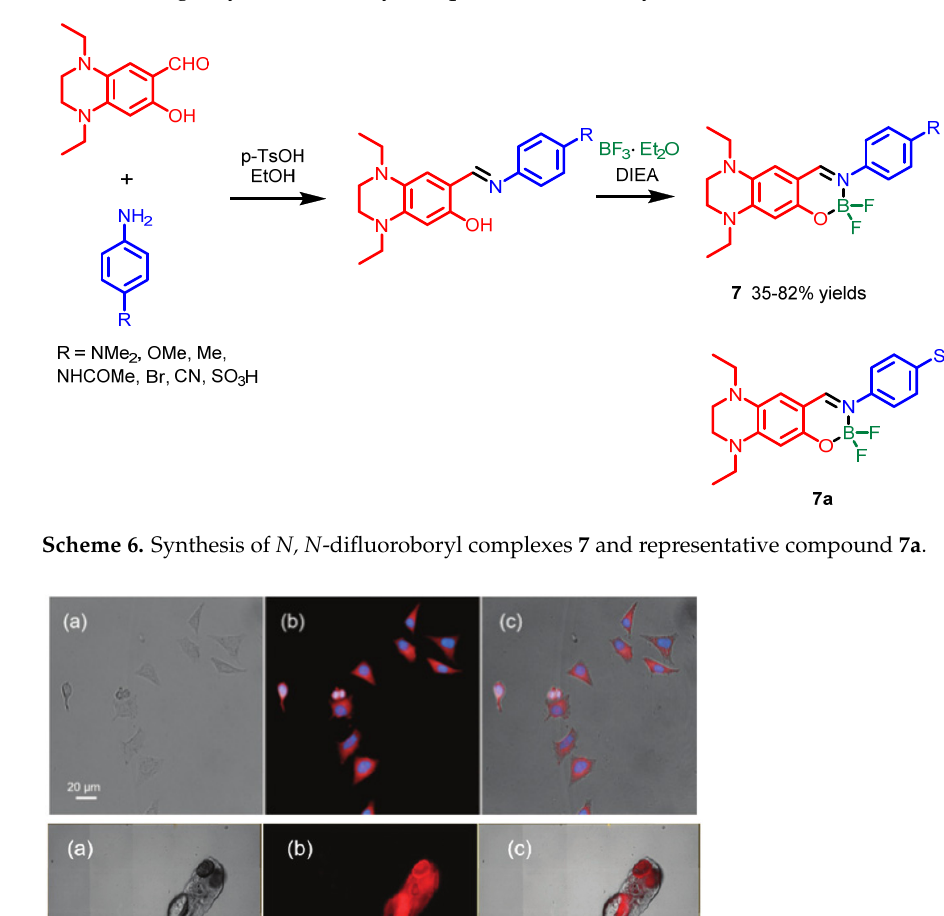
7 of 38 Figure 6. Left : Normalized absorption and fluorescence emission spectra of complex 6 . Right : Con- focal fluorescence images of HeLa cells stained with compound 6 under a red channel. Adapted